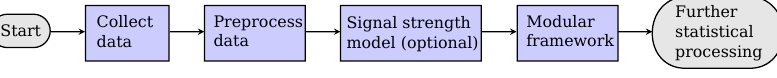
Figure 12: Work flow of mobloc .